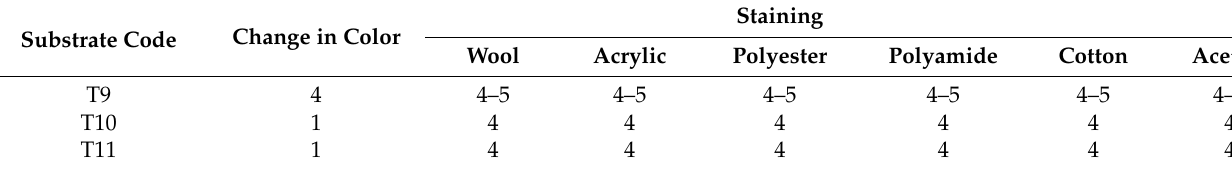
Table 9. Color fastness results